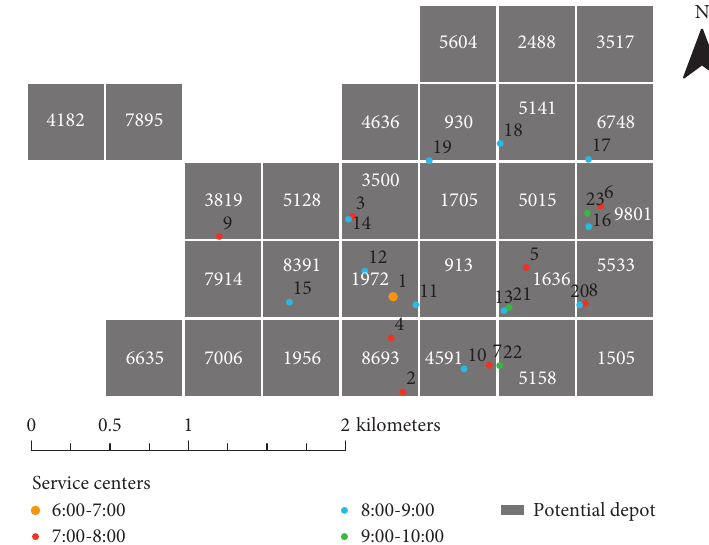
Figure 7: The demo dispatch area information in